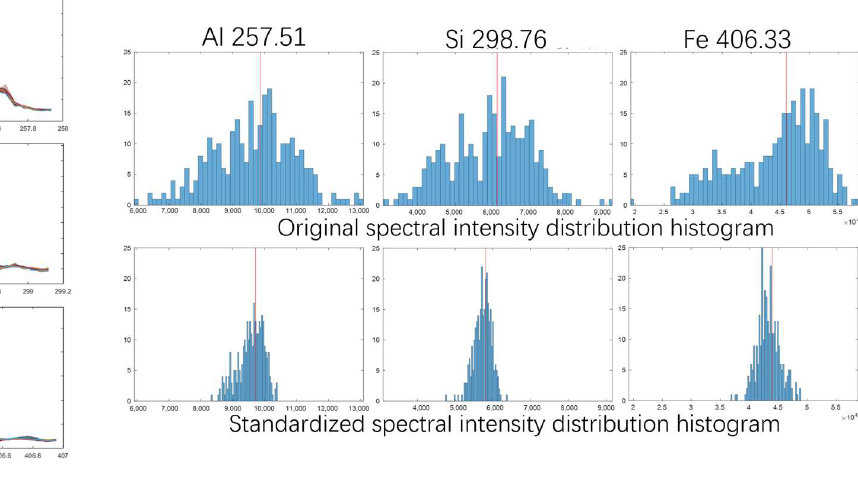
Figure 9. Comparing the KPBP standardization result of the GSS-8 soil sample. ( a ) Eye patterns of characteristic spectral segments. ( b ) Spectral intensity distribution histograms of characteristic spectral lines.